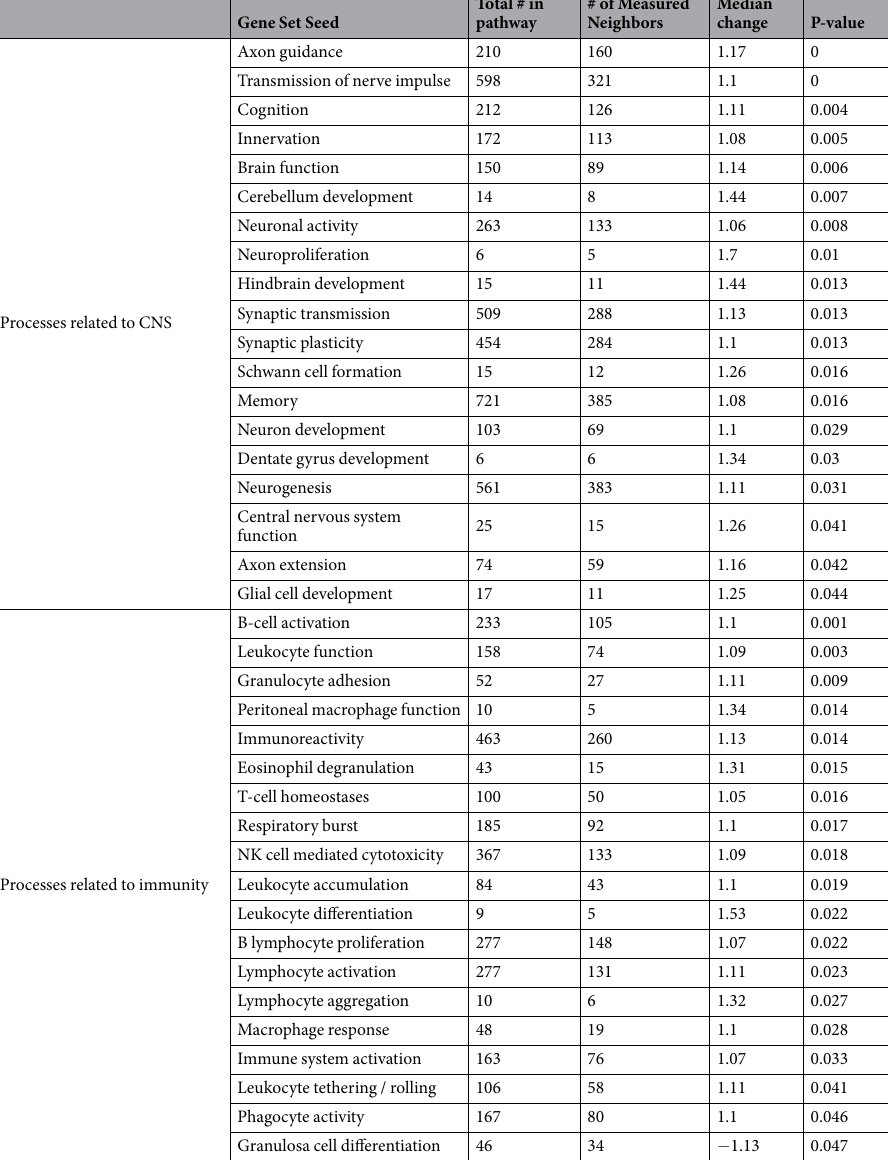
Table 4. Cell processes identified by sub-network enrichment analysis (SNEA) that were regulated by 1000 nM SNa in primary Carassius auratus RGC cultures. Only those sub-networks with a median fold-change greater than 5% in the cell process are presented (P < 0.05). Reported here are only some major cell processes affected by SNa in